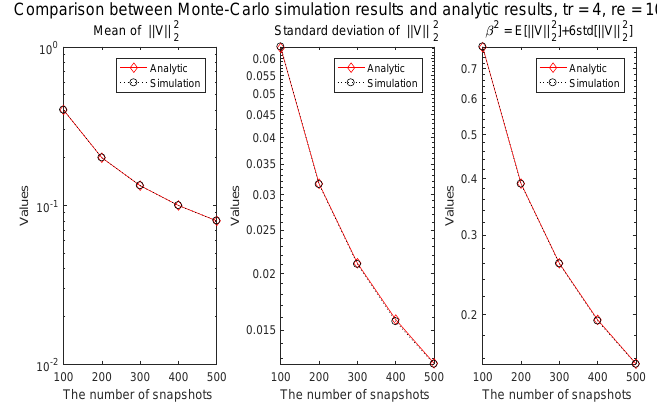
Figure 3. Comparison between the results of the analytic derivation and the results of Monte Carlo simulation (the number of elements of the transmitter = 4, the number of elements of the receiver = 10).